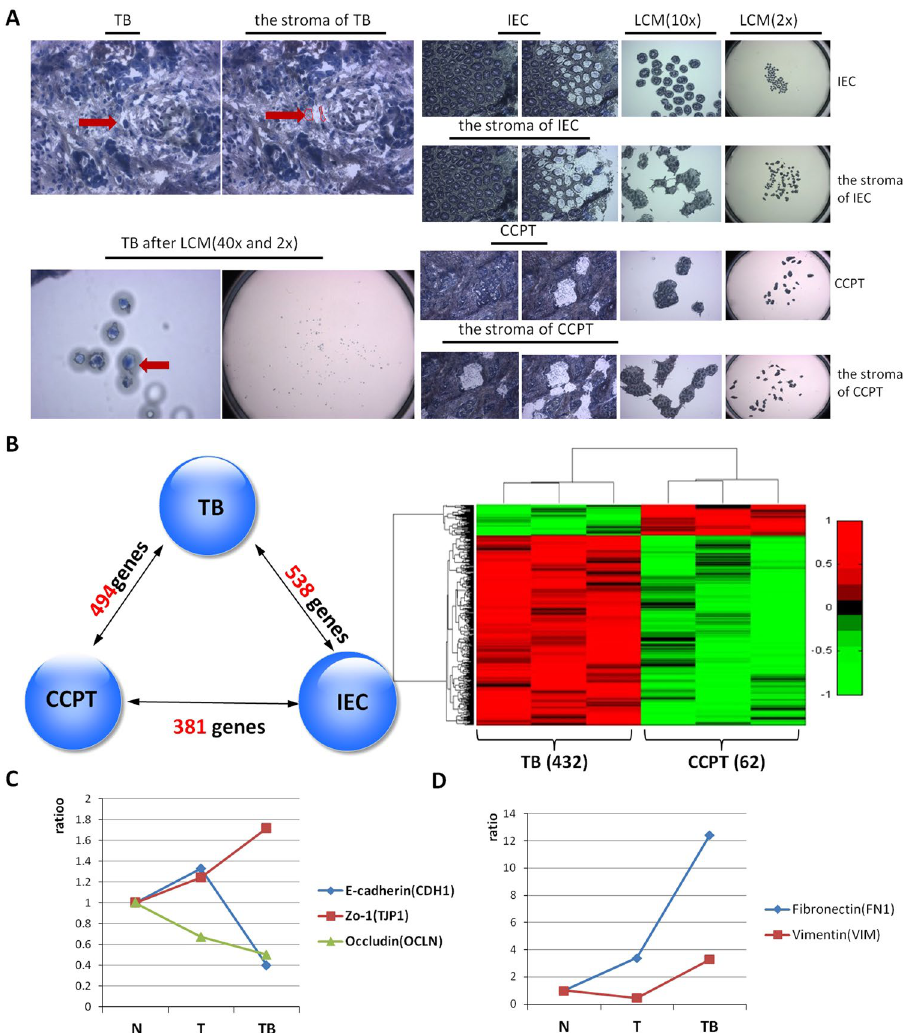
Figure 1. Single-cell capture and gene selection in tumor buds. ( A ) Capture of the tumor buddings (TB) and the surrounding stromal components of tumor buddings (the stroma of TB) with laser capture microdissection, with IEC, CCPT and their stroma as controls. ( B ) Four hundred and ninety-four genes including 432 upregulated genes and 62 downregulated genes that were differentially expressed in the tumor bud samples compared with CCPT, were selected by bioinformatics and statistical analyses ( P < 0.05; FDR = 0.049773; fold change > 2 & < 0.5). ( C , D ) The expression levels of classical epithelial and mesenchymal biomarkers in IEC (N), CCPT (T) and tumor buds (TB). The epithelial markers CDH1 and OCLN were downregulated, and the mesenchymal markers FN1 and VIM were upregulated in the tumor bud